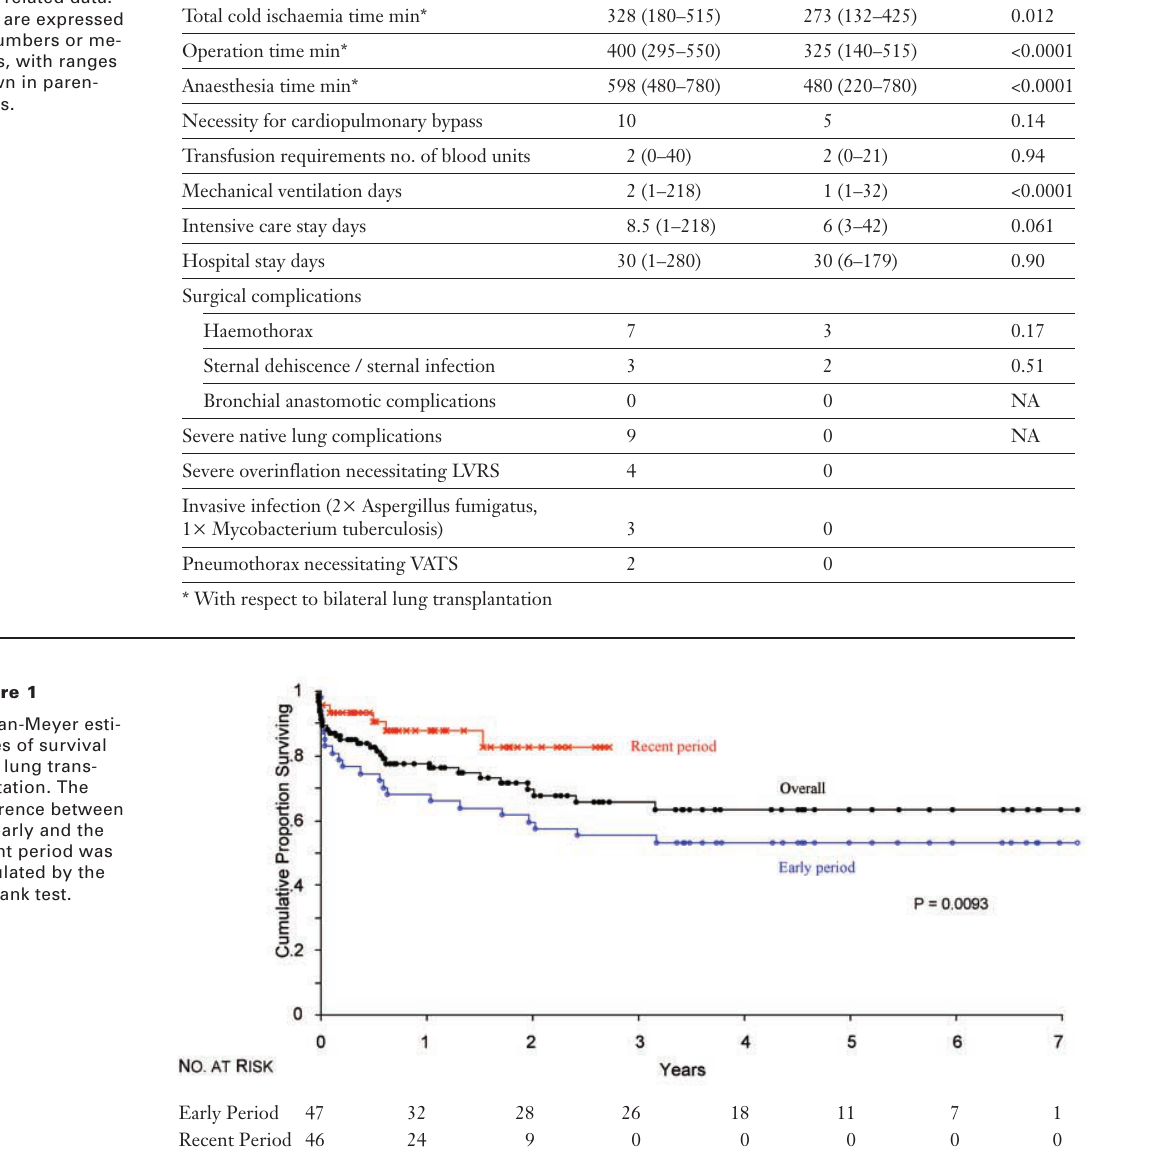
Transplant proce- dure-related data. Data are expressed as numbers or me- dians, with ranges shown in paren- thesis.